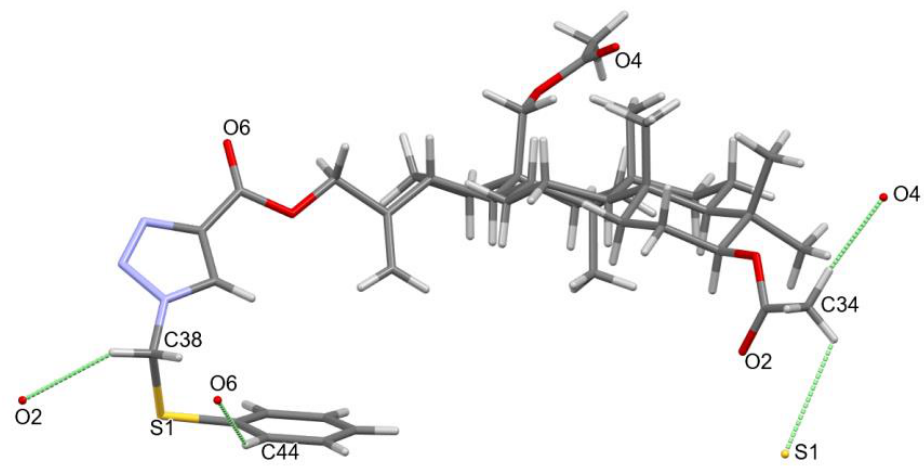
Molecules of 4 are linked to each other by weak C-H . . . O hydrogen bonds. The hydrogen bond parameters are shown in Table 2. All intermolecular hydrogen interactions C-H . . . O determining molecular packing are presented in Figure 4.